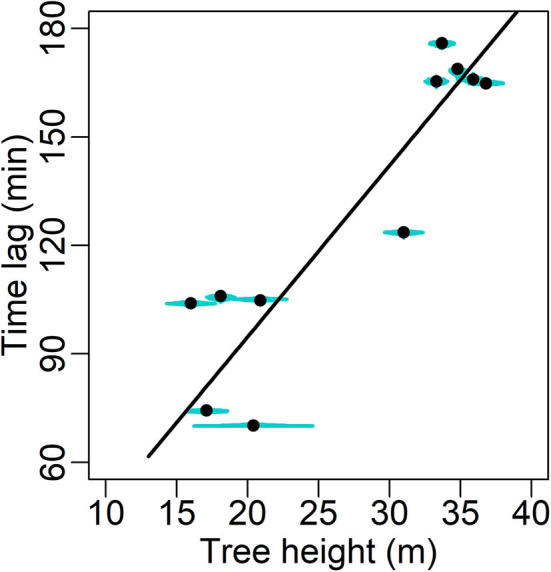
Maxima a posteriori (MAP) estimates (solid circle) of the time lag between sap flow and transpiration (min; Table 3B) with posterior distribution (cyan shade) in relation to tree height. The fitting's form y = 4.74 x, R2 = 0.814, P < 0.0001.